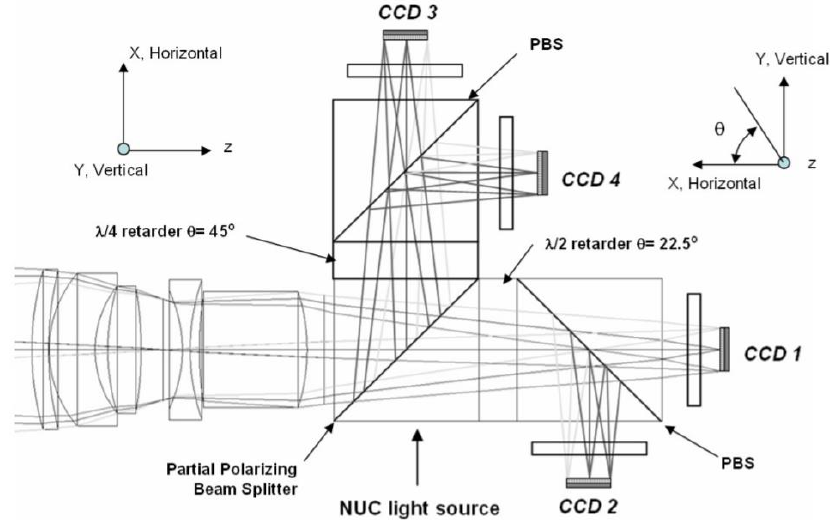
Figure 6. Schematic diagram of full polarization state of fractional amplitude measurement [27].